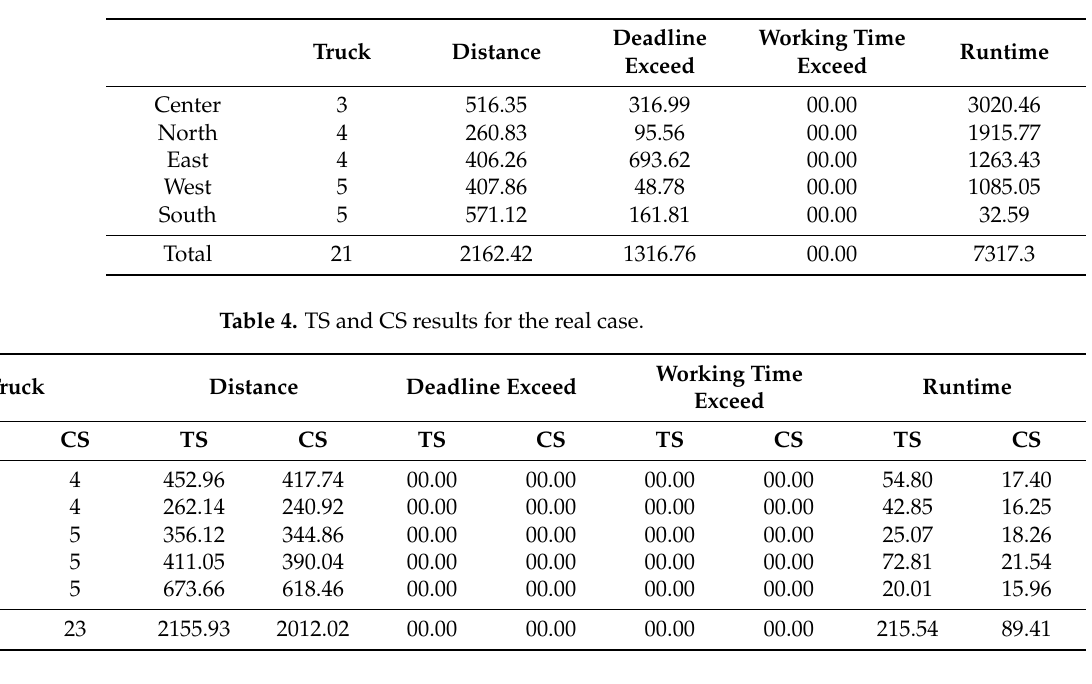
Table 3. Summary of the results obtained by the company data using GAMS.